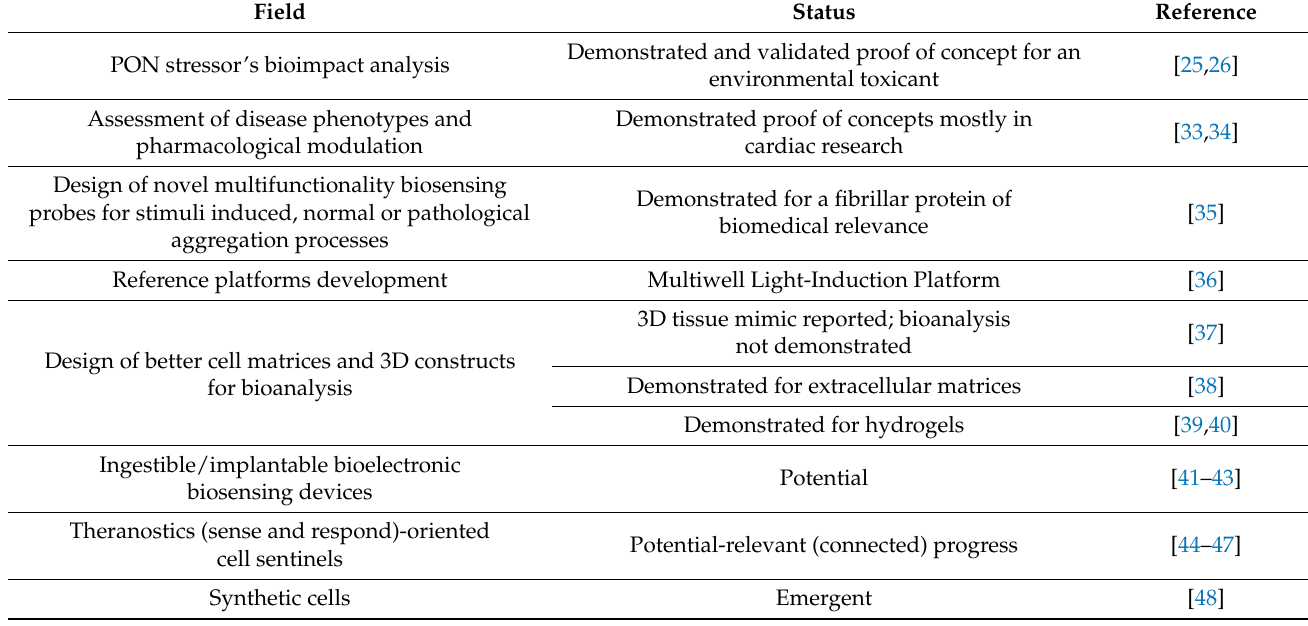
Table 1. Potential applicative fields of optogenetics-powered cell-based biosensing and cellular reporters.